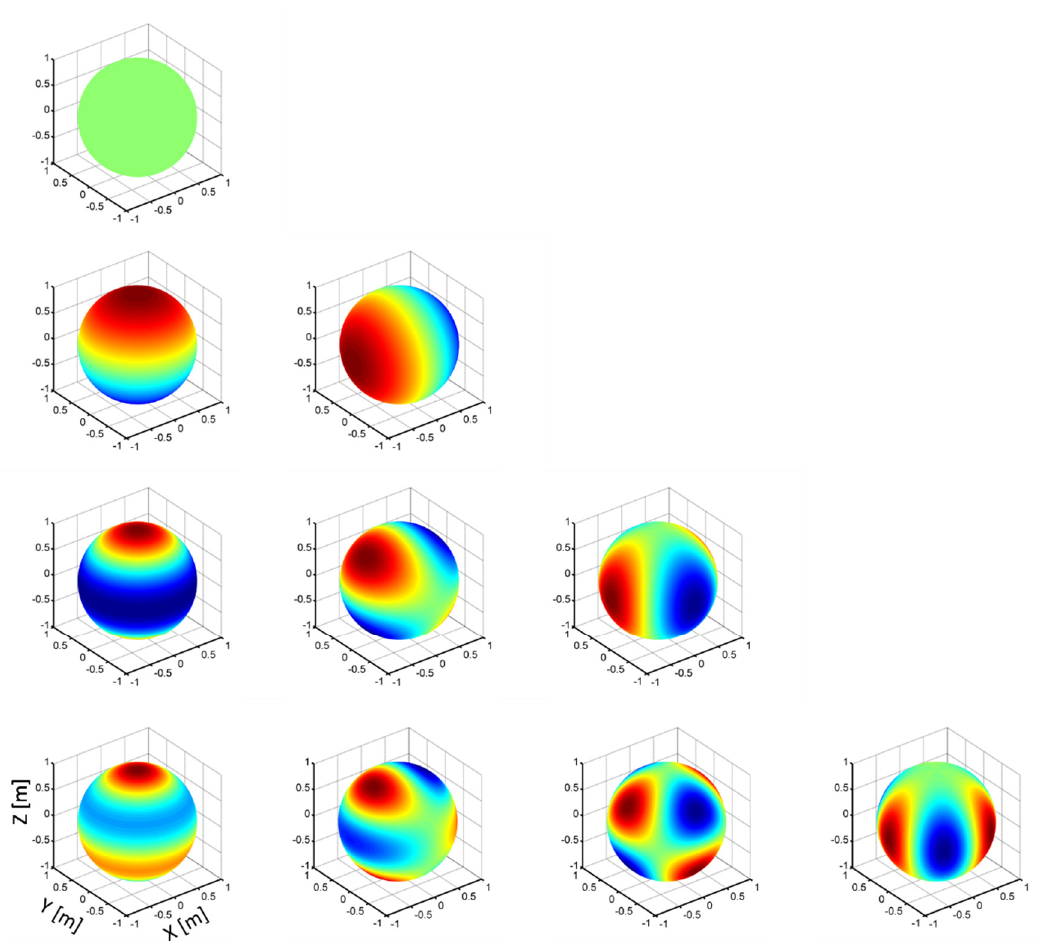
( θ , ϕ ) for l = 0,1, 2,3 (top to bottom) Y θϕ for 0,1,2,3 l = (top to l l